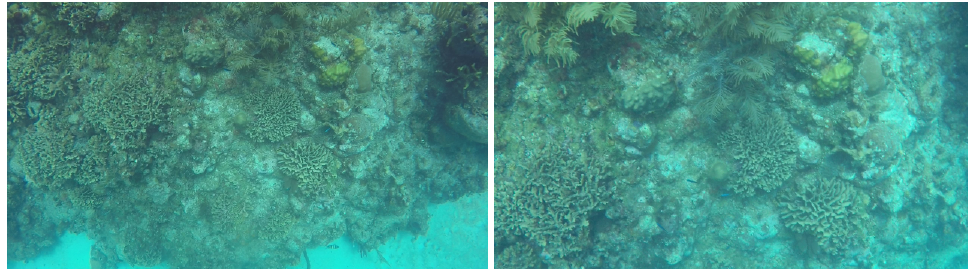
Figure 7. Example of images taken from the same place but at different distances from the